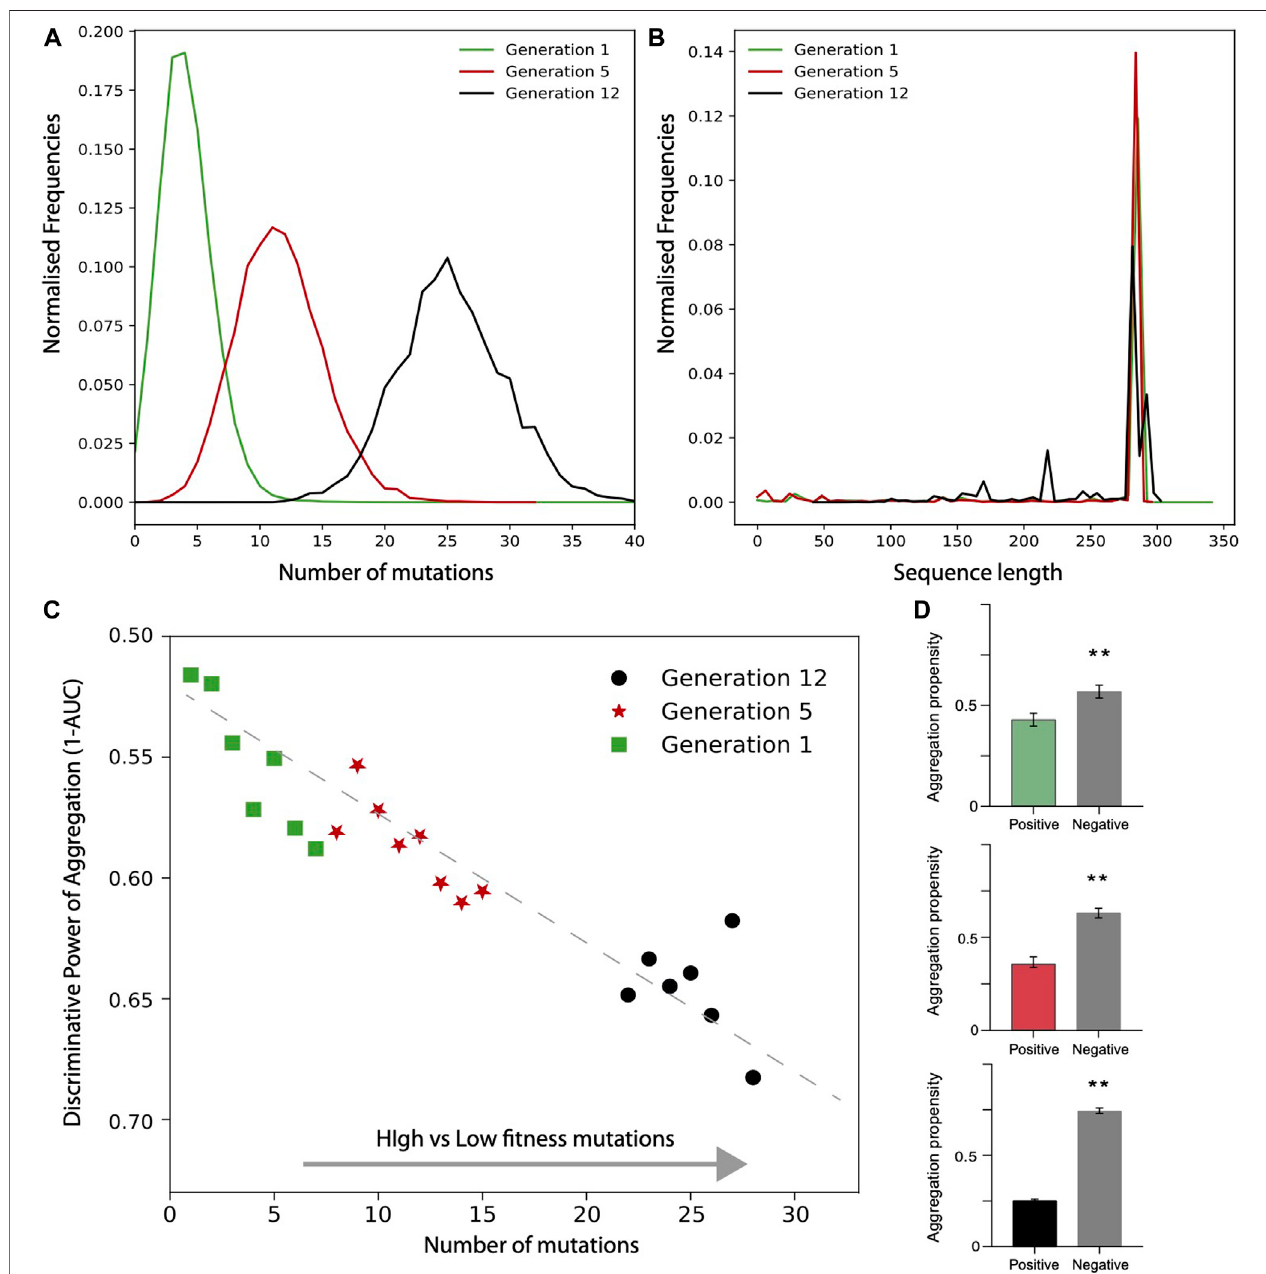
FIGURE5| DeepscanningexperimentsofTEM-1beta-lactamasemutantsexpressedin E.coli .Distributionof (A) mutationnumbersand (B) sequencelengthsfor different generation of evolution. (C) AUC value as a function of high vs low fi tness data sets (data computed only for sub data set with at least 1000 data points). (D) Aggregation propensities of mutations associated with the highest (top 100) and random (100 cases) fi tness scores for generation 1,5, 12 (**, p -value < 0.01, Kolmogorov-Smirnoff test). The colors match the points in the (D) .